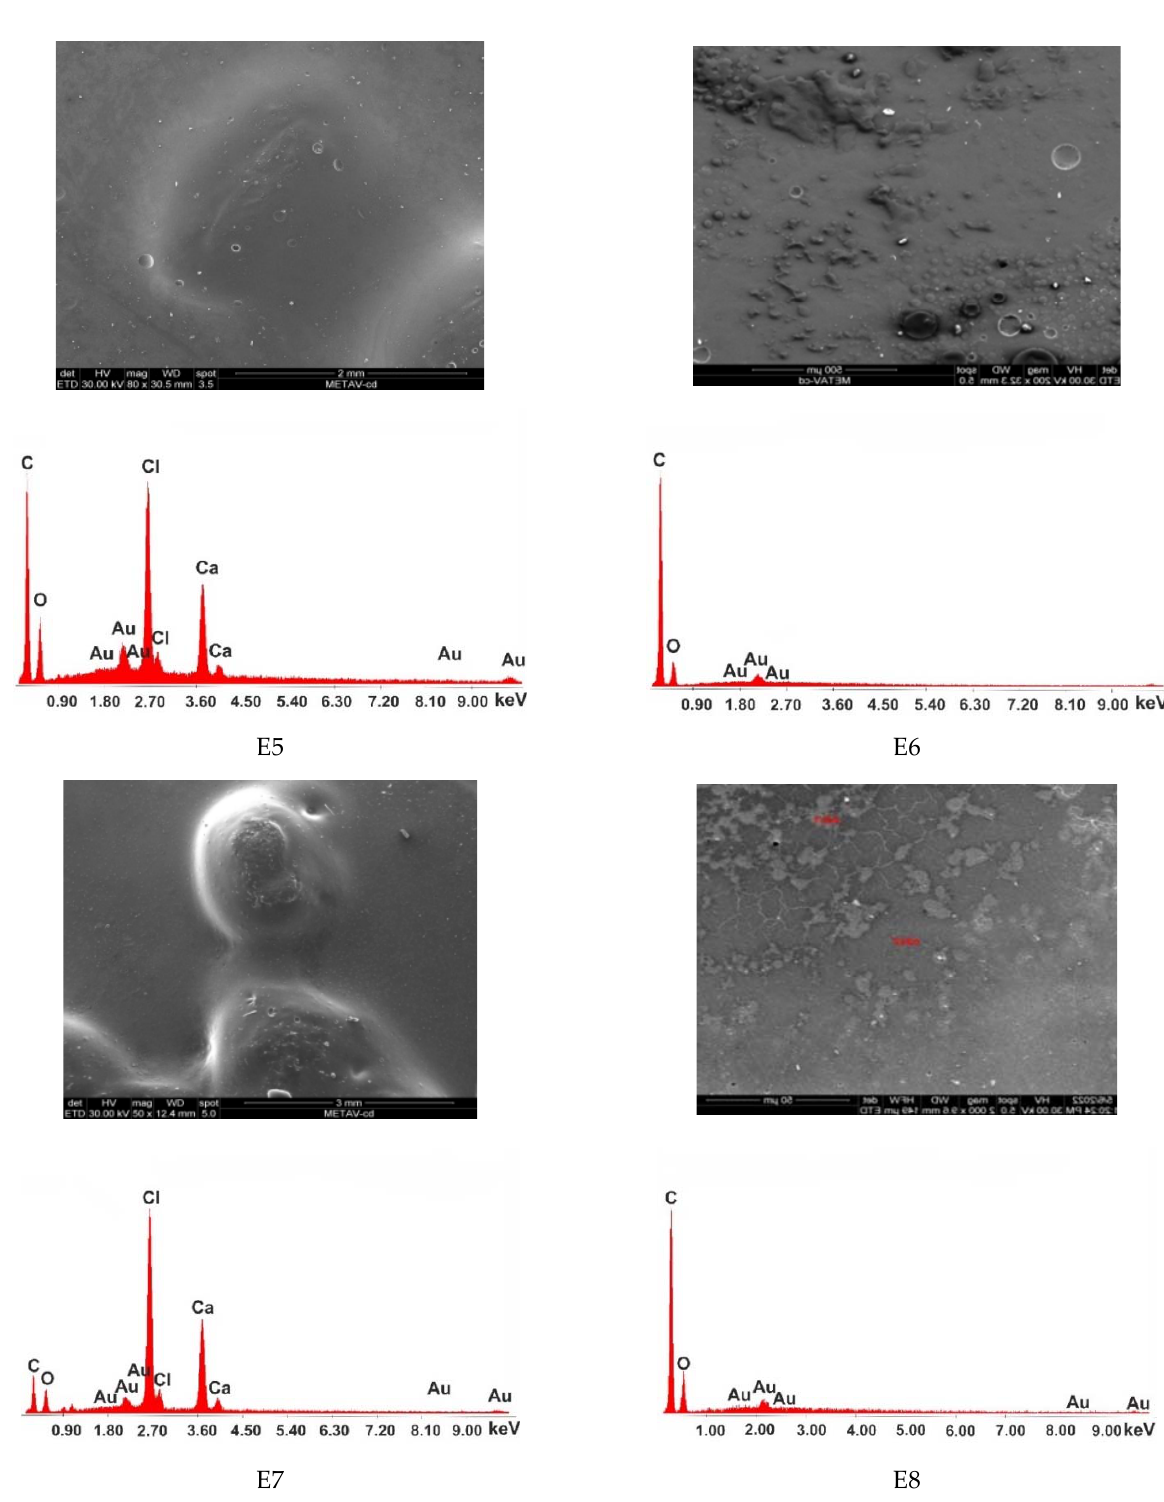
Figure 11. SEM micrographs and EDAX diagrams of compositions E1–E8. The EDAX spectra of samples E1, E2, E4, E6, and E8 reveal two main components of the matrices, namely carbon and oxygen. In contrast, the EDAX spectra of samples E3, E5, and E7 show the two major components of the polymeric matrix to be carbon and oxygen, together with another two main components covering the shell of the microcapsules, namely Ca and Cl.